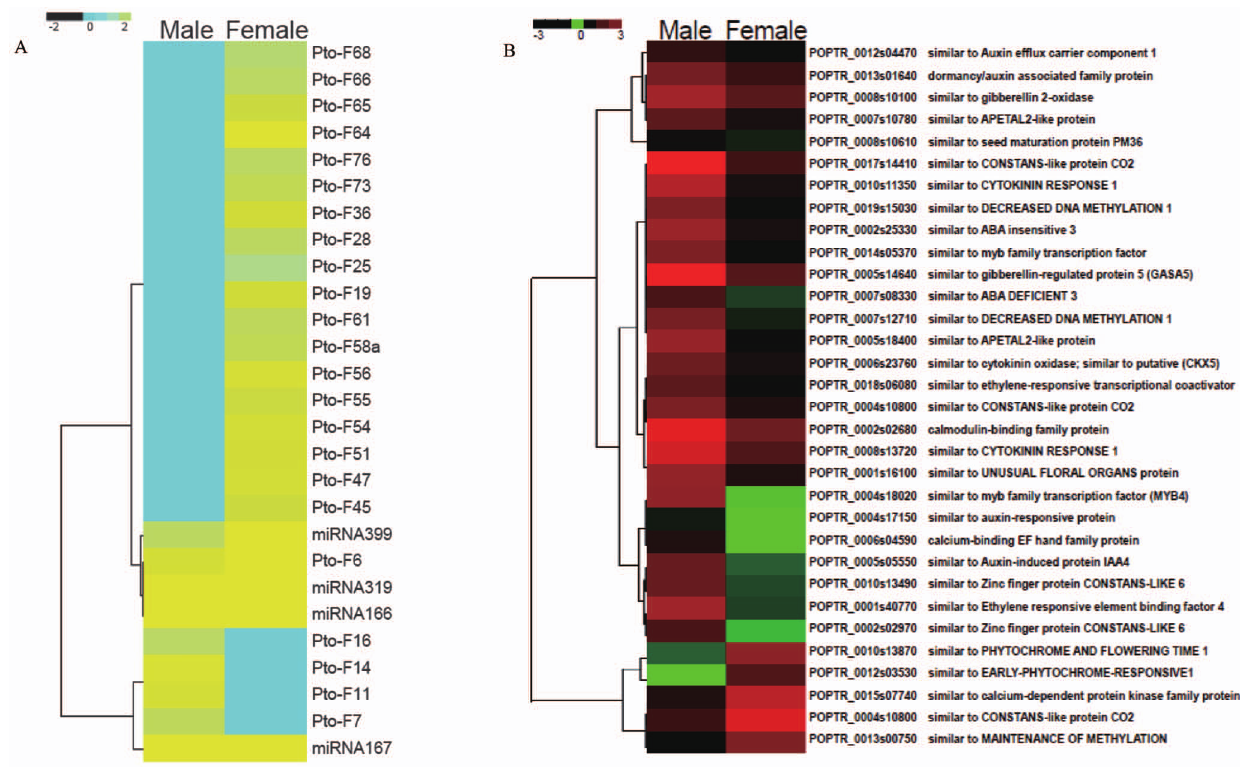
Figure 6. Pearson correlation Coefficient (PCC) heat map representing expression of miRNAs and their targets in andromonoecious poplar flower organs. Red and yellow indicate higher levels of transcriot and green and blue indicate lower levels of transcript. The names of samples are shown at the top. The gene model and gene annotation are shown on the right side. A: Heatmap of conserved and novel miRNAs. B: Heatmap of target genes.